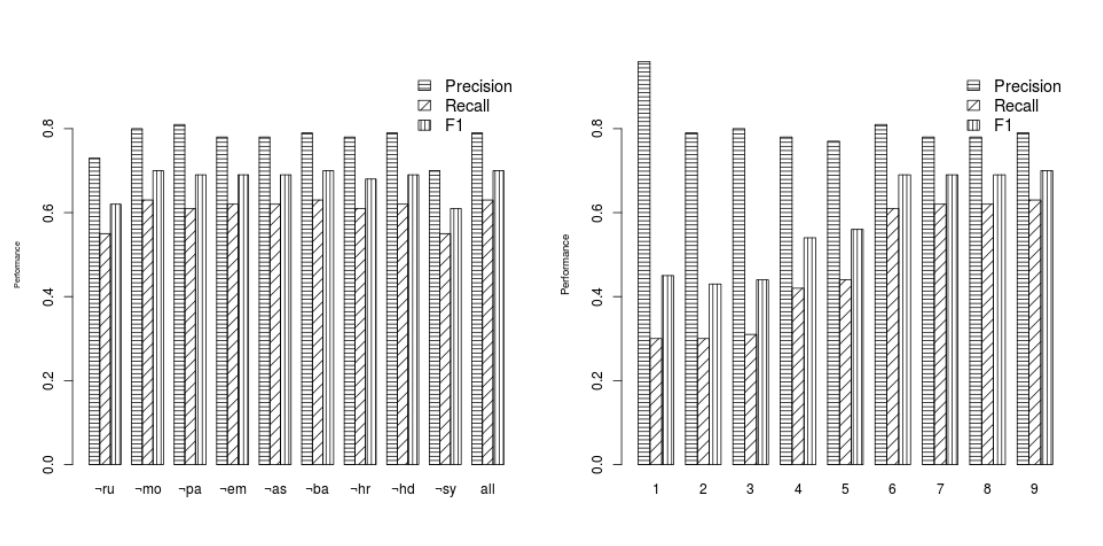
Figure 6: Evaluating the contribution of each module to the overall output by leaving out one at a time, using Dataset 2